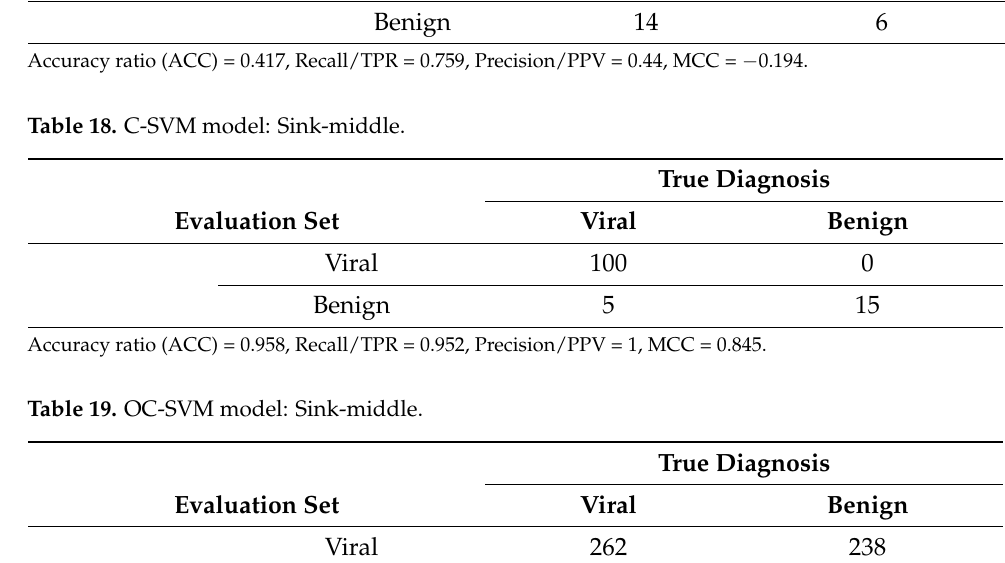
Table 17. OC-SVM model: Sinkhole. True Diagnosis Evaluation Set Viral Benign Sinkhole Viral 44 56 Benign 14 6